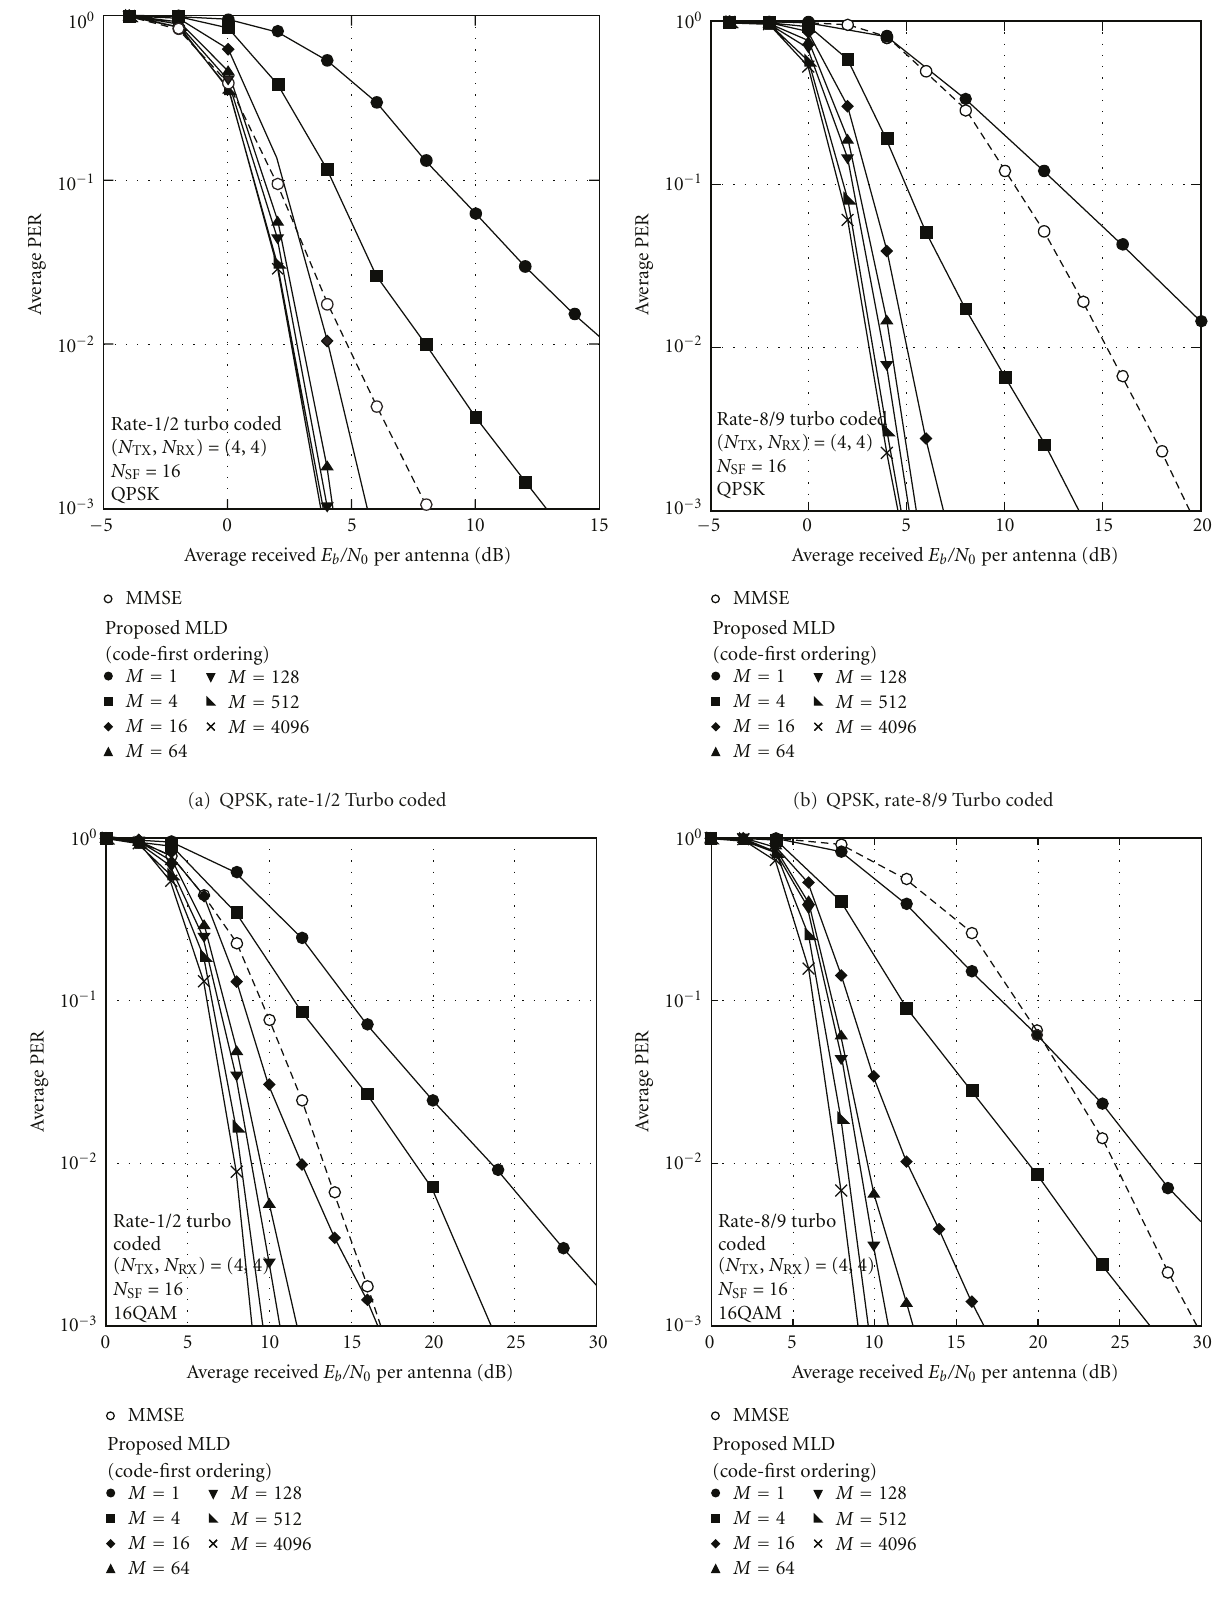
Figure 9: Average PER as a function of average received E b /N 0 for various modulation schemes and coding